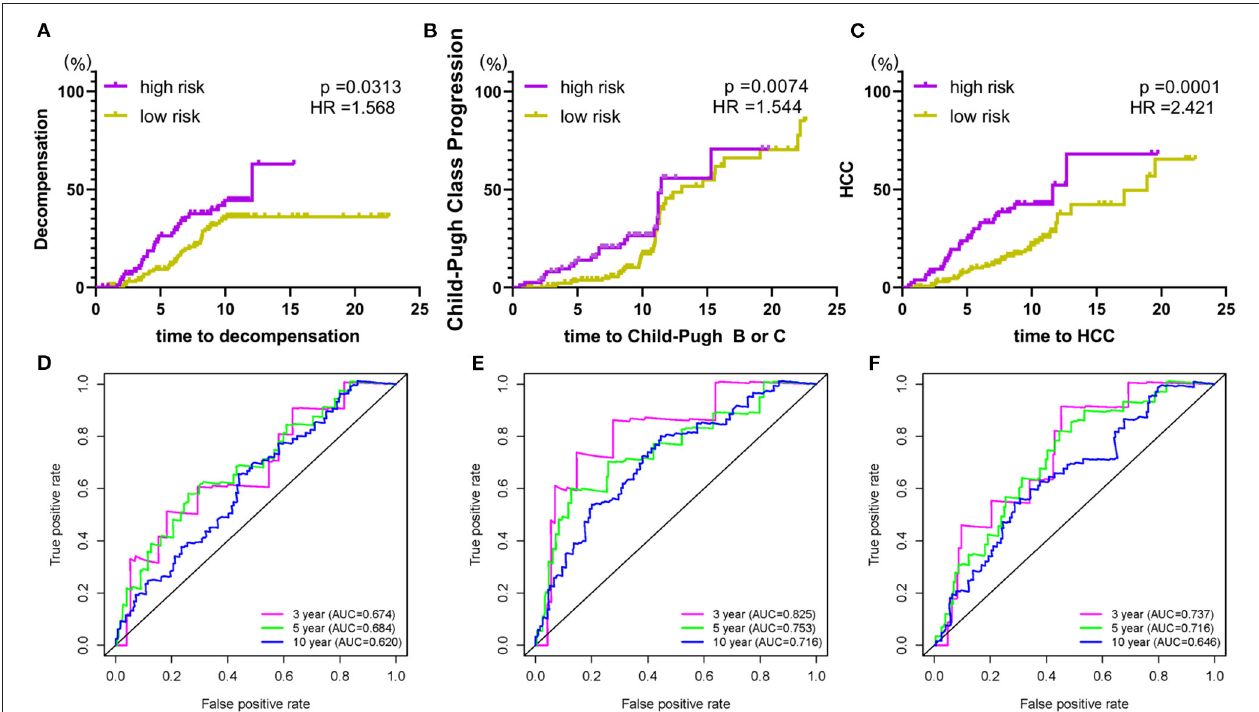
FIGURE 3 | The prognostic signature is associated with poor clinical endings. (A) risk score and hepatic decompensation; (B) risk score and Child-Pugh class progression; (C) risk score and HCC. (D–F) The time-dependent ROC curve analysis for verification of the index on different malignant clinical events. Hazard ratios and p-values were given for the difference between the high and low-risk groups.